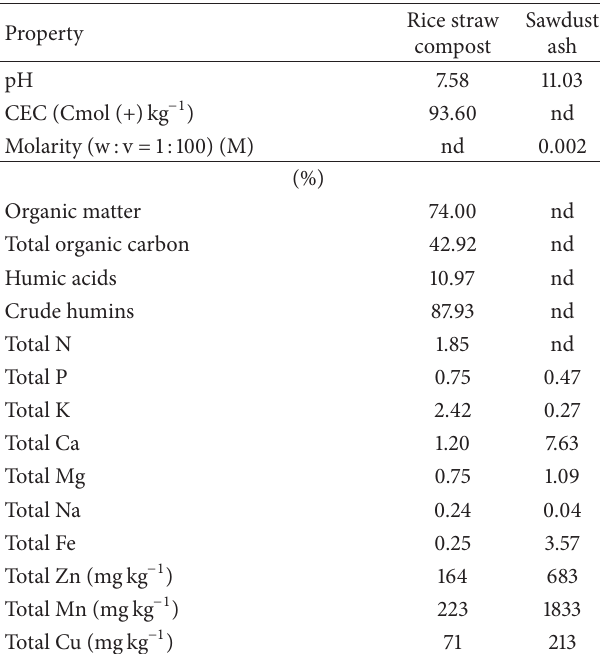
Table 2: Selected chemical properties of rice straw compost and sawdust